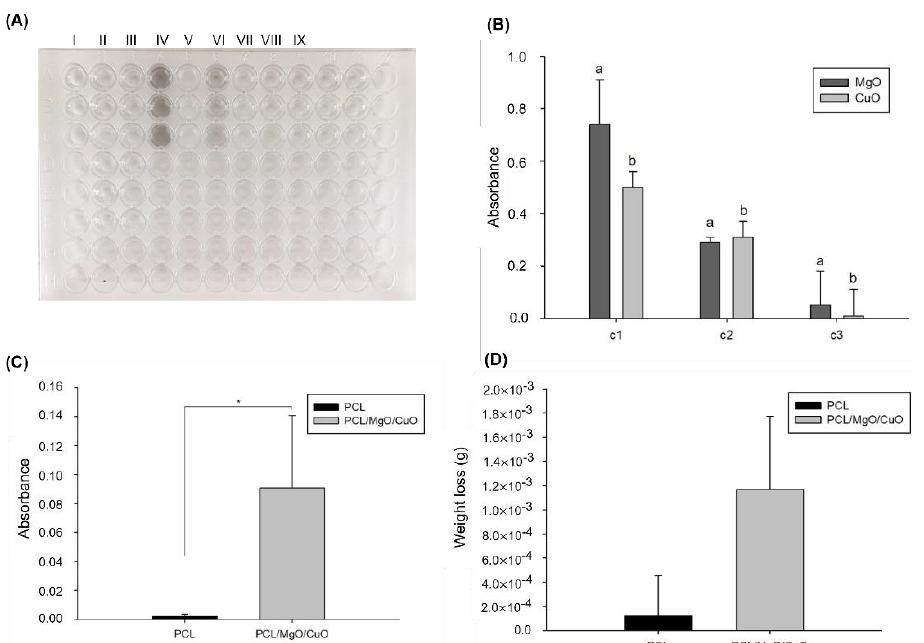
Figure 6. Stability test during washing process of electrospun filters. ( A ) 96-well plate used in the spectrophotometry assay for metal oxide NPs released quantification (I — control; II — PCL mesh; III — PCL/MgO/CuO; IV — CuO 100%; V — MgO 100%; VI — CuO 50%; VII — MgO 50%; VIII — CuO 1%; IX — MgO 1%); ( B ) Absorbance representing 100% (c1), 50% (c2), and 1% (c3) of the total amount of nanoparticles (measured at 400 nm); ( C ) Absorbance of the aqueous medium for 2 h of washing (measured at 400 nm); ( D ) Weight loss during washing process. Differences between conditions were evaluated all pairwise using Tukey’s test. Bars with the same letters have statistically signifi- cant differences ( p > 0.05). Statistical significance for p ≤ 0.05 (*).